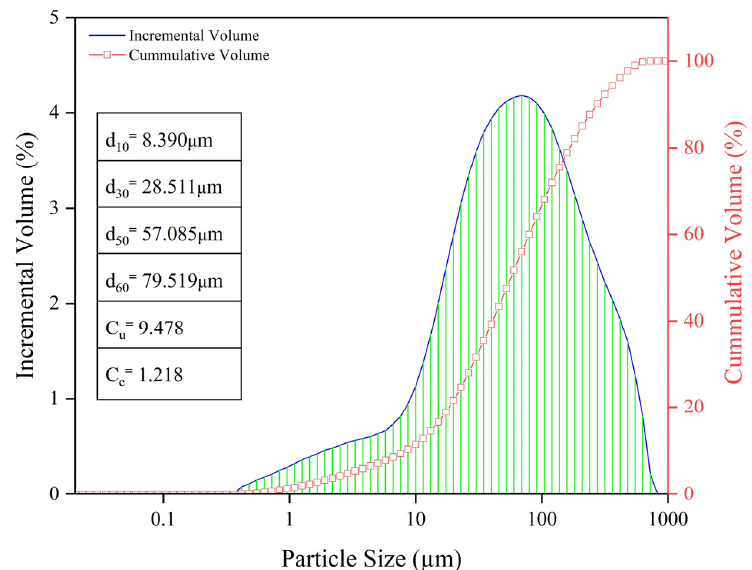
Figure 5. Particle size distribution of